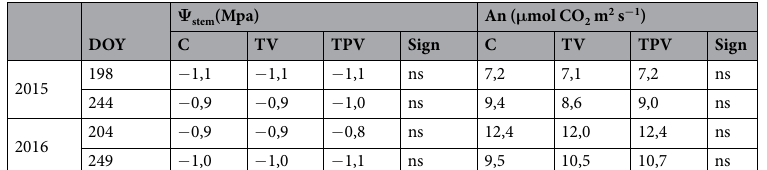
Table 1. Values of midday stem water potential ( Ψ stem ) and leaf net assimilation rate (An) for the treatments and the control, recorded in pre-veraison, before the beginning of the experiment, and at mid maturation stage, in the two seasons of study (2015–2016). Data are means for measurements on six fully exposed leaves per treatment. Treatment effect is reported (ns: not